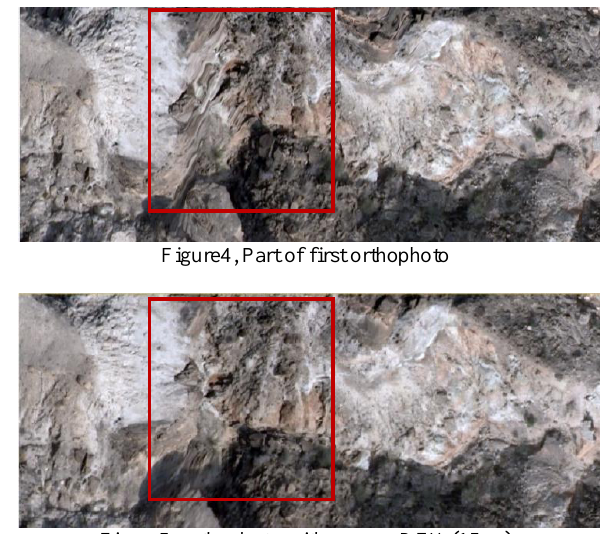
Figure5, orthophoto with sparser DEM(15 m) Differences of highest to lowest place are about 100 meters